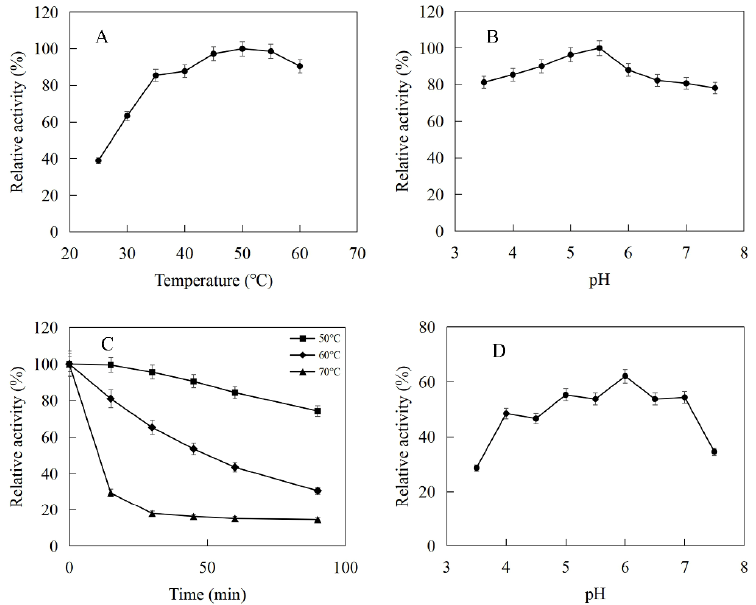
Figure 4. Effects of pH and temperature on the activity and stability of EcPK: ( A ) Effect of temperature on the activity of EcPK. ( B ) Effect of pH on the activity of EcPK. ( C ) Thermostability of EcPK. ( D ) pH stability of EcPK.